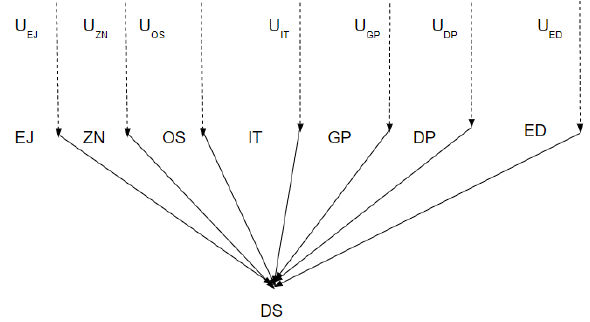
Figure 1. A graphical representation of the model.